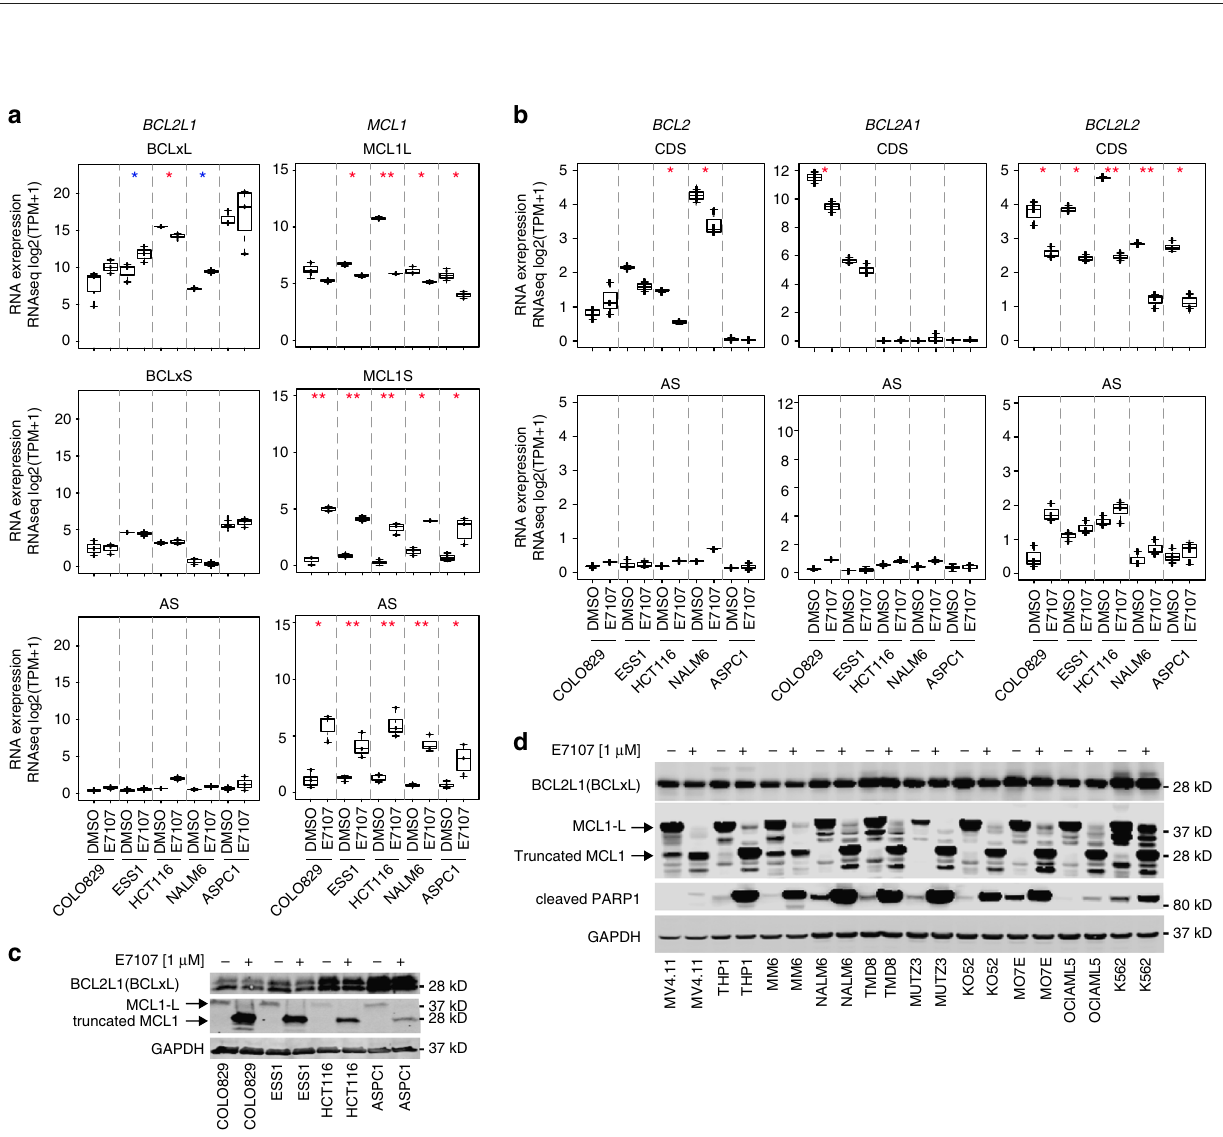
Fig. 3 Antiapoptotic BCL2 family genes exhibit differential sensitivity to E7107-induced splicing modulation. a RNA-seq analysis of BCL2L1 and MCL1 upon E7107 treatment (at GI50) in cancer cell lines COLO829 (35 nM for 6 h), ESS1 (16 nM for 6 h), HCT116 (50 nM for 6 h), NALM6 (15 nM for 6 h), and ASPC1 (41 nM for 6 h). RNA expression levels represent RNA reads for corresponding coding sequence (CDS) of the functional protein isoforms (L antiapoptotic long form, S proapoptotic short form) or aberrant splicing (AS) events that are not predicted to encode functional proteins. b RNA-seq analysis of BCL2 , BCL2A1 , and BCL2L2 under same conditions shown in a . * p < 0.01, ** p < 0.001; red asterisks: proapoptotic events with median expression log 2 (TPM + 1) > 2, blue asterisks: antiapoptotic events with median expression log 2 (TPM + 1) > 2. c Western blot analysis of BCLxL and MCL1 protein expression upon treatment with E7107 (1 μ M for 6 h). GAPDH was used as the loading control. d Western blot analysis of BCLxL, MCL1, and cleaved PARP1 protein expression in a panel of leukemia cell lines upon treatment with E7107 (1 μ M for 6 h). GAPDH was used as the loading control